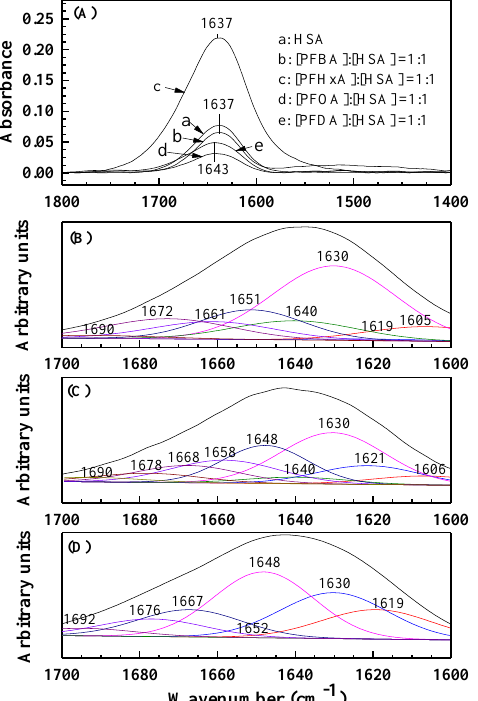
ff erence spectra [(PFBA–HSA) – PFBA